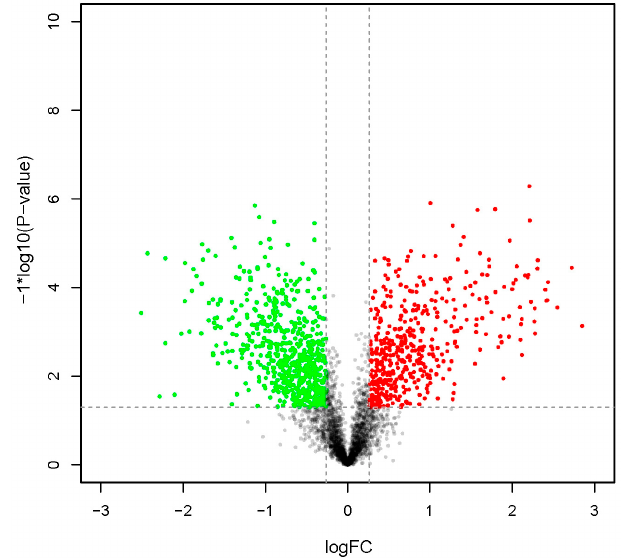
Figure 1. Change in global protein abundance between the post-larval stage (PL) and the competent larval stage (CL). LogFC represents log 2 Ratio (PL/CL); proteins with log 2 Ratio (PL/CL) >0.26 or < − 0.26 are colored ( red for fold changes >1.20 and green for <0.83).